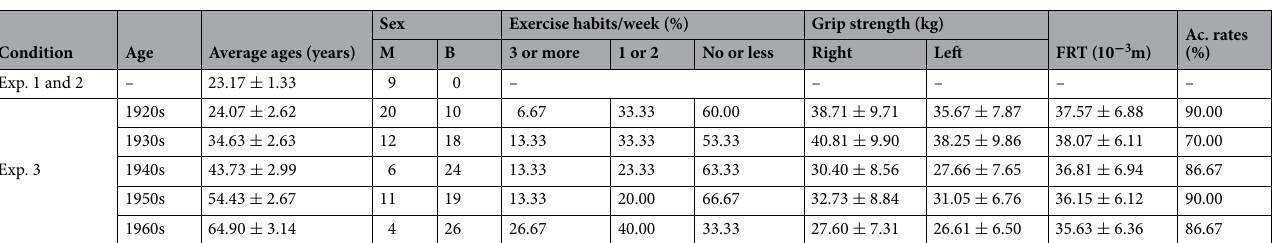
Figure 3. Hardware components and experimental equipment for the prototype system. ( A ) 3D motion capture-based light-touch system for experiments 1 and 2. IR marker attached to the subject’s trunk and fingertip with virtual force computation based on subject motion. The computer also generates stimulation signals for fingertip feedback. ( B ) Wearable light-touch device used for experiment 3. The subject’s motions are monitored using the fingertip acceleration sensor. Virtual forces are determined on a microcomputer based on acceleration, and fingerpad feedback is provided in line with motion. A webcam is used to record subject movement.